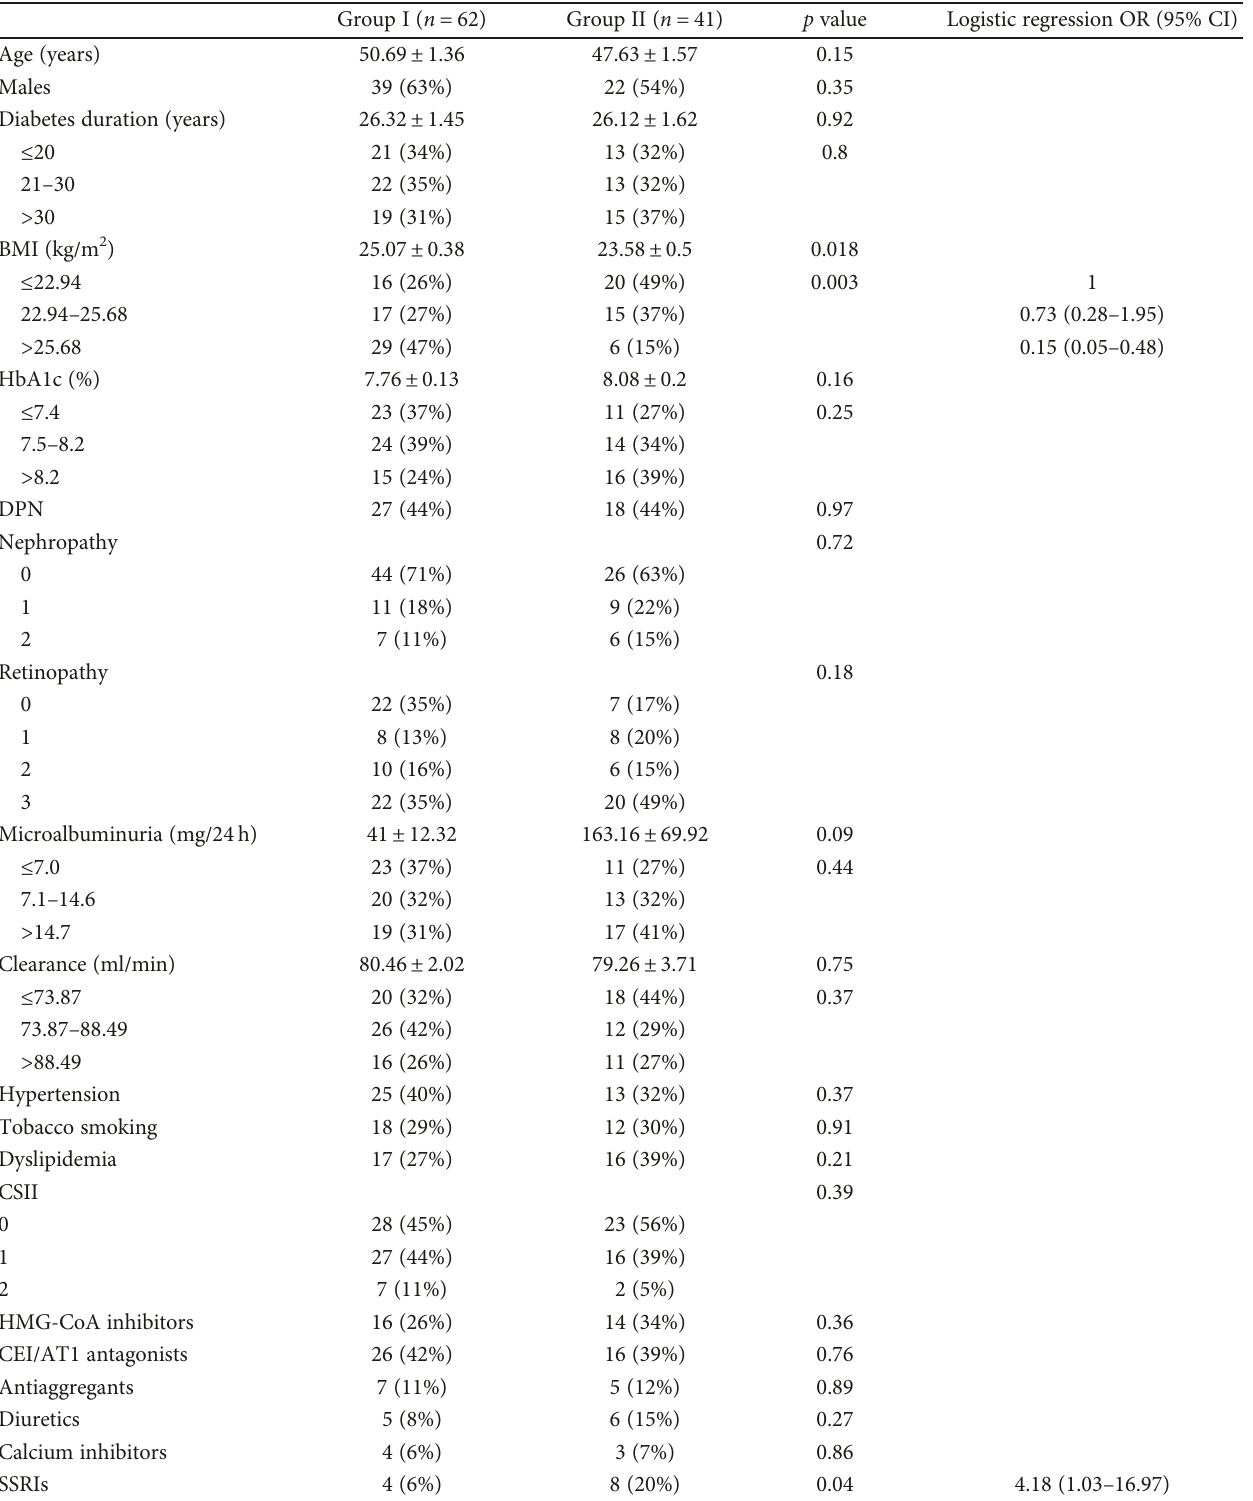
Table 2: Baseline clinical and biochemical characteristics of type 1 diabetic patients with mild CAN who remained stable (group I) or had CAN worsening (group II) for over a mean period of 3